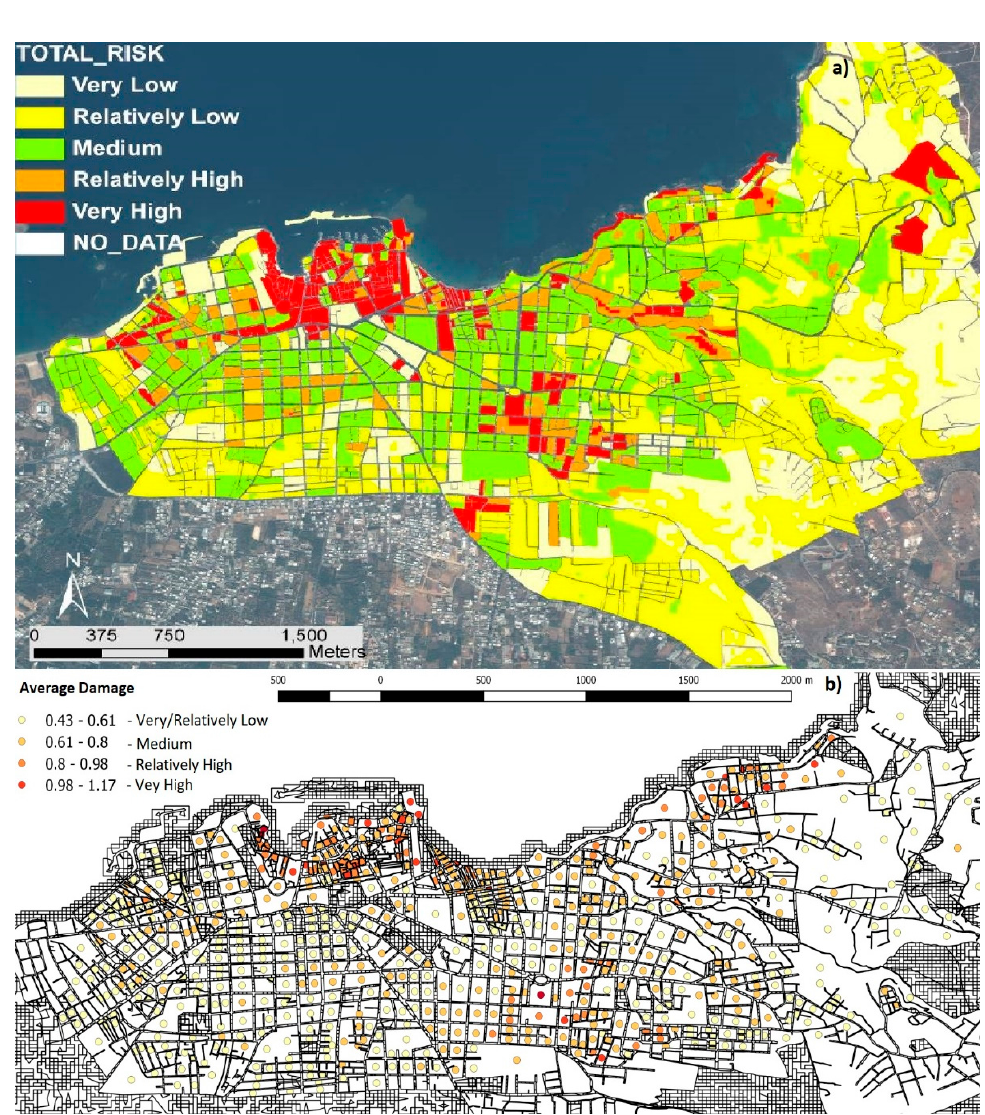
Figure 6. Comparison of Chania risk maps produced by ( a ) Sarris et al. [26] and ( b ) the QuakeIST model of the current study.